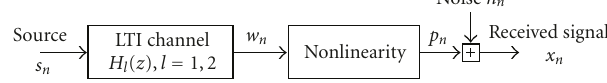
Figure 3: The model of the nonlinear channel for which adaptive equalization is needed.